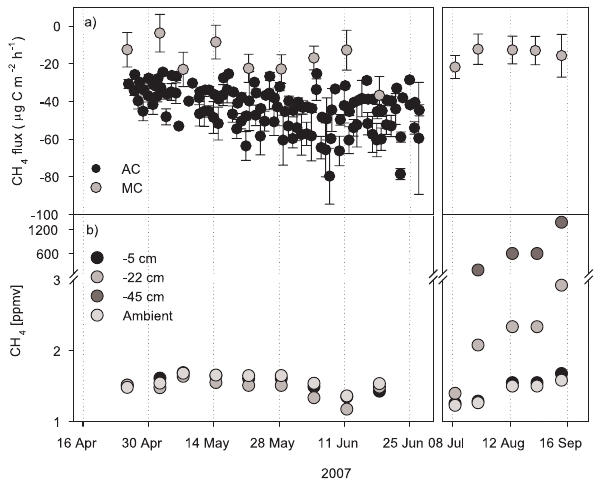
Fig. 5. (a) Daily mean fluxes of CH 4 measured with automatic (AC, n =9) and manual (MC, n =16) chambers, (b) soil concentrations of CH 4 at three depths and in the ambient air measured at the drained peatland. First column of the figures represent the period of inten- sive measurements, the second shows the data outside the measure- ment campaign. Error bars stand for standard errors of the mean.